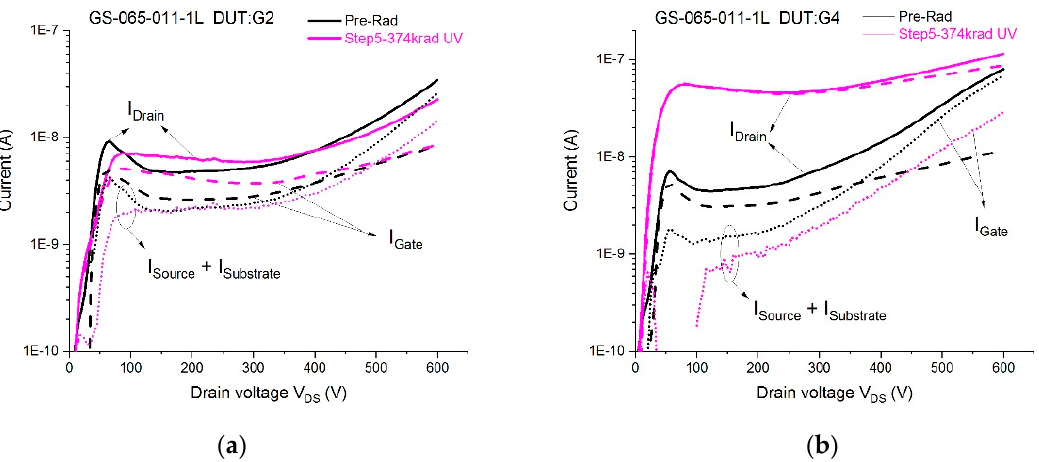
Figure 7. The leakage currents versus drain voltages in the off state (V GS = 0 V) before (black lines) and after (magenta lines) gamma radiation with a total ionising dose of 374 krad(SiO 2 ) at a base temperature of 133 °C. ( a ) Device G2 stressed during irradiation with V DS = 500 V and V GS = − 5 V. ( b ) Device G4 stressed during irradiation with V DS = 500 V and V GS = 0.